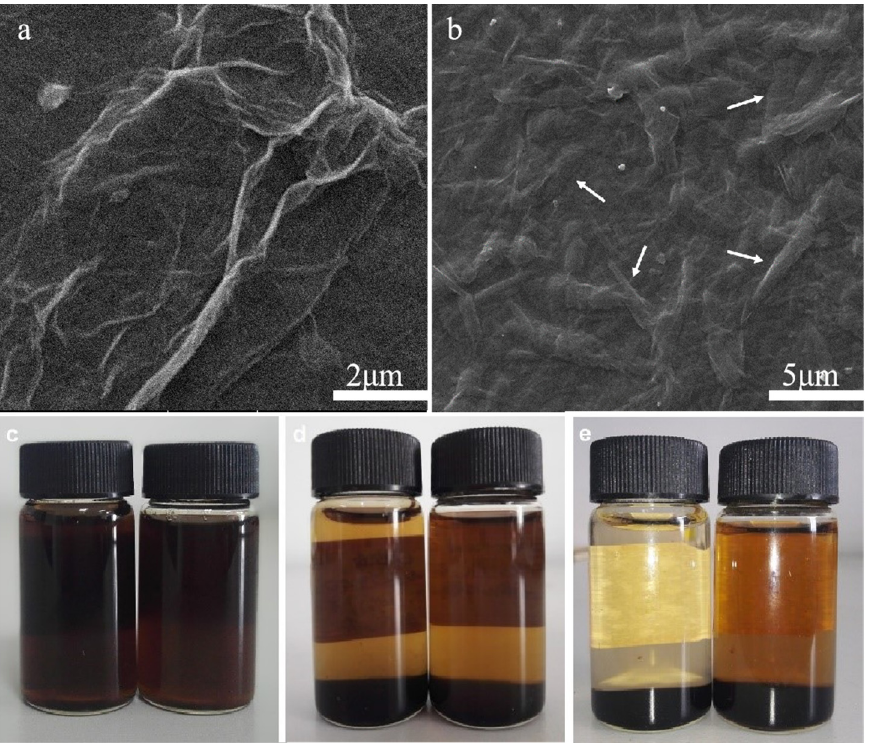
Figure 6. Microscopic and macroscopic morphologies of the samples during sample preparation. ( a ) SEM image of graphene oxide (GO); ( b ) SEM image of GO plus 1 g MCC composite (GO/C-1 g); ( c – e ) the photos of GO (left) freeze-dried powder and GO/C-1 g (right) freeze-dried powder dispersed in water on the 1st, 6th, and 78th days, respectively.